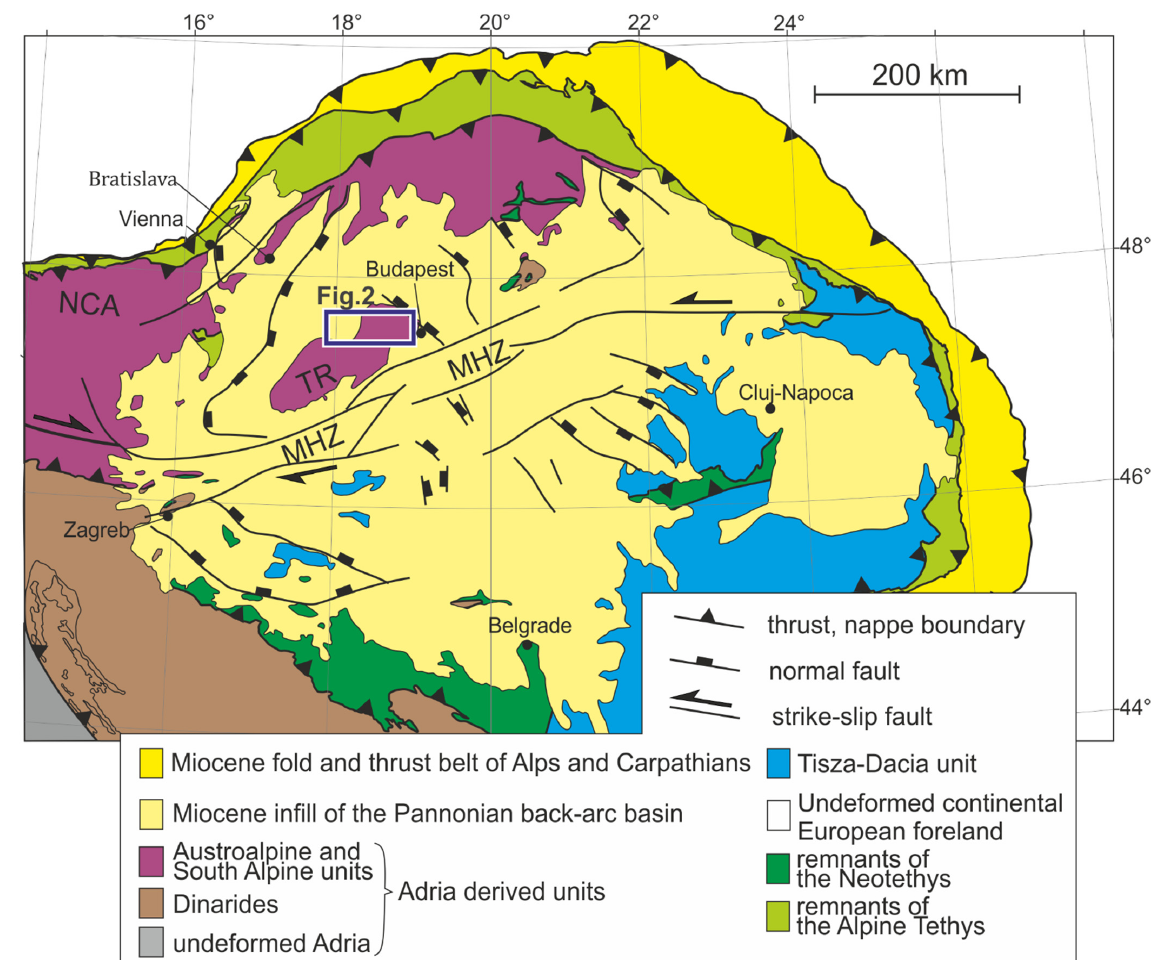
Figure 1. The position of the study area within the Pannonian Basin ([20] modified) fault pattern is based on [21] NCA = Northern Calcareous Alps, TR = Transdanubian Range, MHZ = Mid-Hungarian Shear Zone. The abbreviations “Fig.” refer to figures of this work.